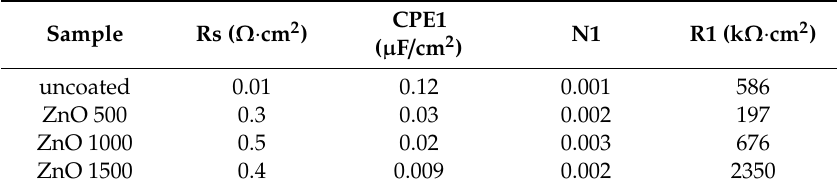
Figure 8. An equivalent circuit representing the impedance spectra of the investigated materials. Table 2. Values obtained during EIS